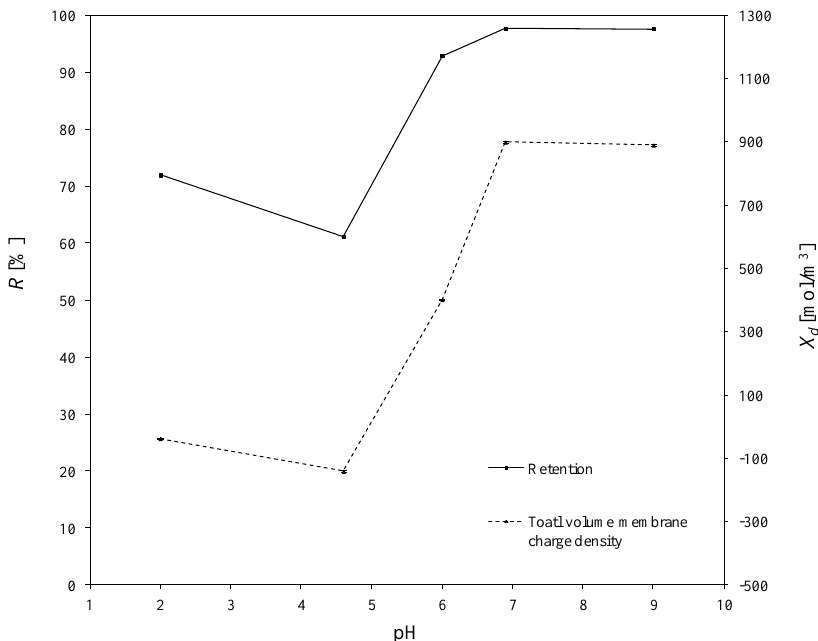
Figure 4. The influence of pH on the total volume charge density in aqueous solution of Cu(NO 3 ) 2 and the influence of pH on the Cu 2+ retention. Retention values obtained experiments.